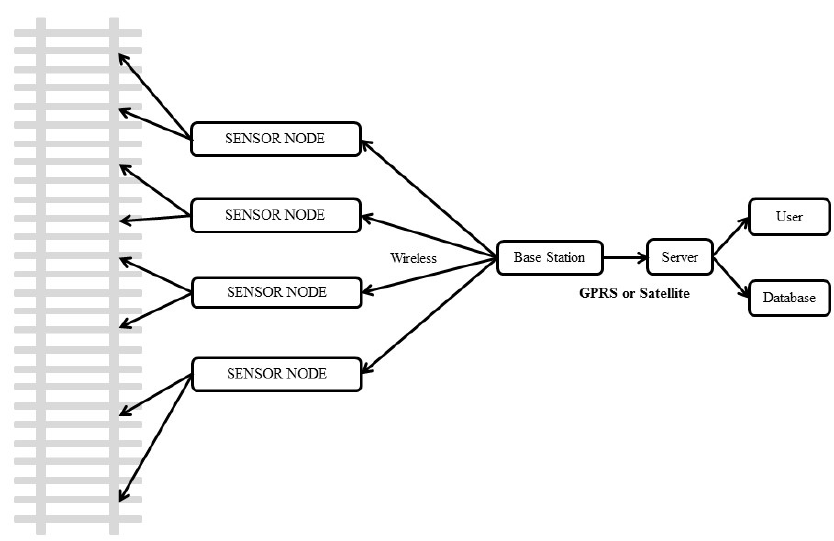
Figure 2. WSN framework [46].